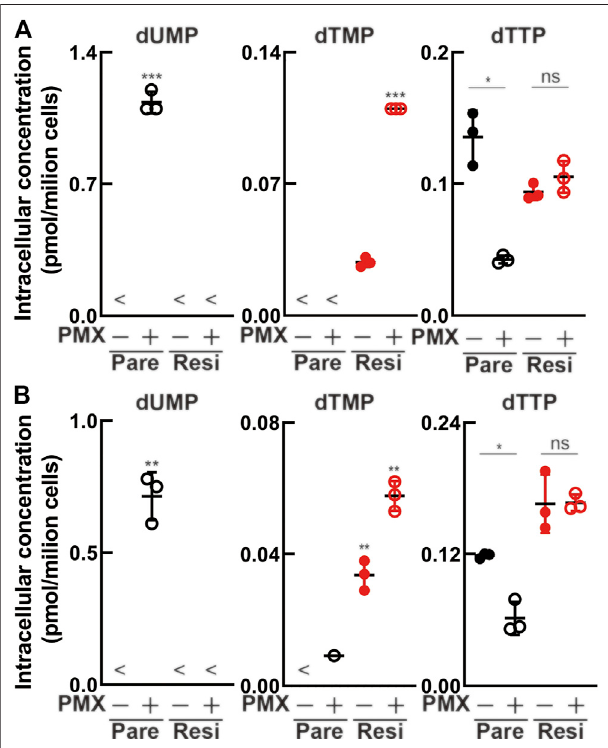
FIGURE 4 | TYMS overexpression increased resistance to pemetrexed (PMX). MSTO-211H or TCC-MESO-2 cells were transfected with control vector (Vector) or TYMS-overexpressing vector (TYMS+) derived from retrovirus. (A) Protein levels of TYMS or β -tubulin (TUBB) in whole-cell lysates, determined by western blot analysis. TUBB was used as a loading control. (B) Viability of transfected cells treated with the indicated concentration of PMX for 72 h, determined by WST-8 assay. The % viability data are shown as the mean ± standard deviation (SD) (n (cid:2) 6). Error bars indicate the range of SD.